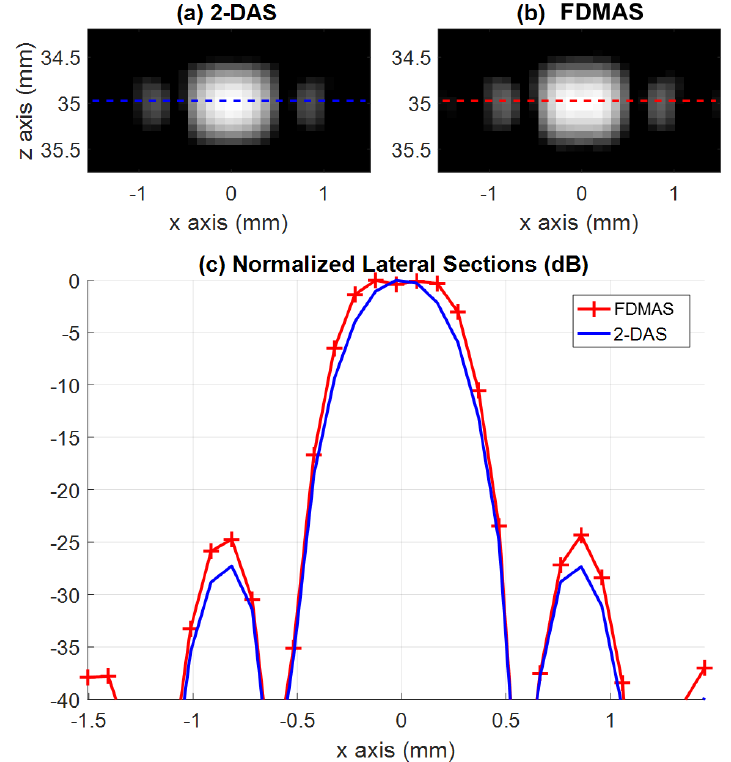
Figure 7. Comparison of PSFs obtained with 2-DAS and FDMAS. The scatterer was placed at ( x 0 = 0 mm, z 0 = 35 mm) on the numerical phantom. B-mode log-compressed images are shown over a 40-dB dynamic range for 2-DAS ( a ) and FDMAS ( b ). Their respective normalized lateral profiles are shown in ( c